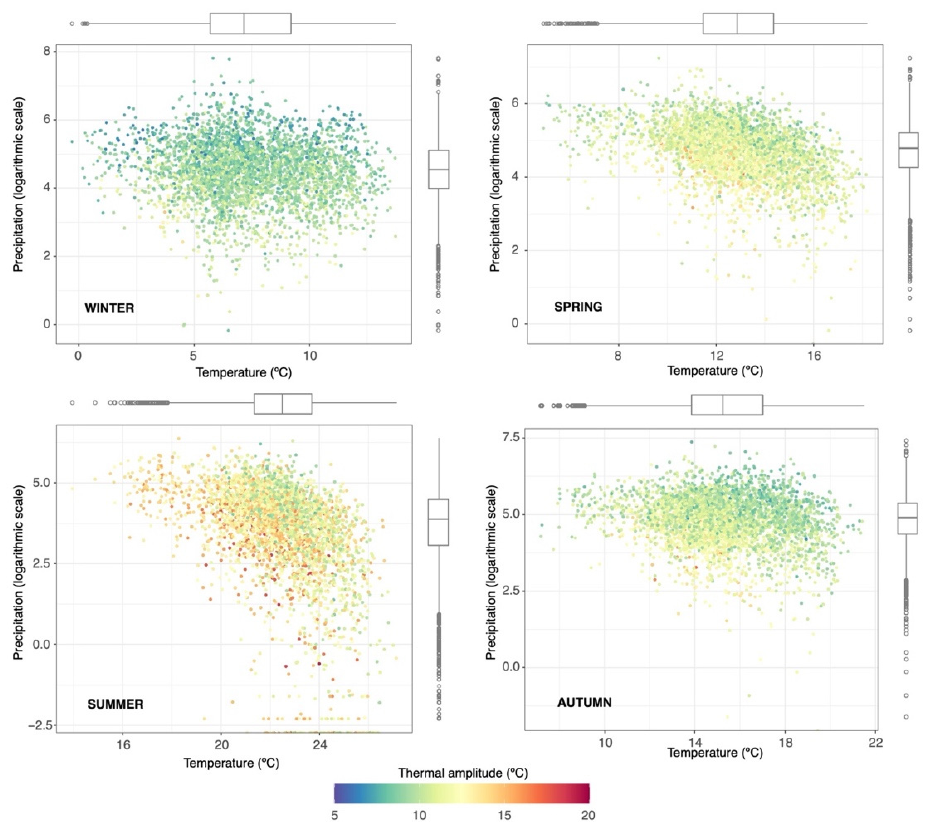
Figure 2. Seasonal variability of the temperature and precipitation. Dots represent the average seasonal values at the grid points covering the study area. Color scale indicates the difference between the maximum and minimum temperatures. Boxplots summarize the frequency of the temperature and precipitation for each season.